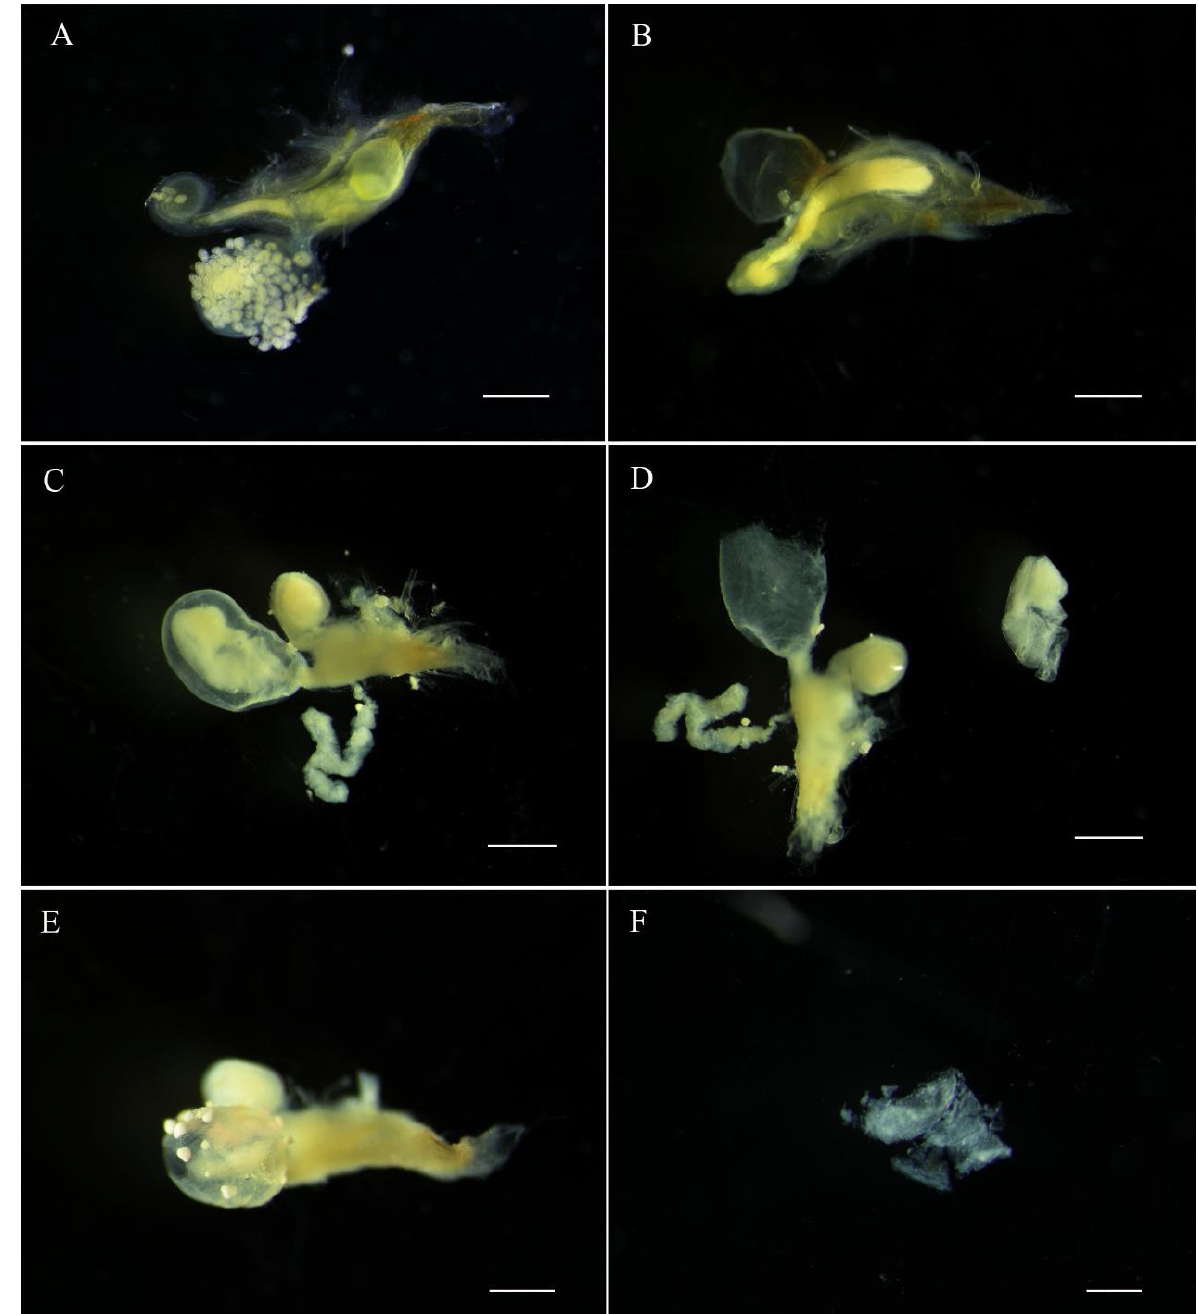
Figure 5. Position and digestion of male spermatophore in bursa copulatrix of female Emeia pseudosauteri at various times after copulation. ( A ) Thirty minutes after copulation: tip of spermatophore near spermatheca and not within spermatophore-digesting gland. ( B ) Sixty minutes after copulation: tip of spermatophore has entered spermatheca but not in spermatophore-digesting gland. ( C , D ) Twelve hours after copulation: spermatophore partially digested in spermatophore- digesting gland. ( E , F ) Forty-eight hours: spermatophore almost digested in spermatophore-digesting gland. Scale bars for ( A – E ): 0.5 mm, ( F ): 0.2 mm.